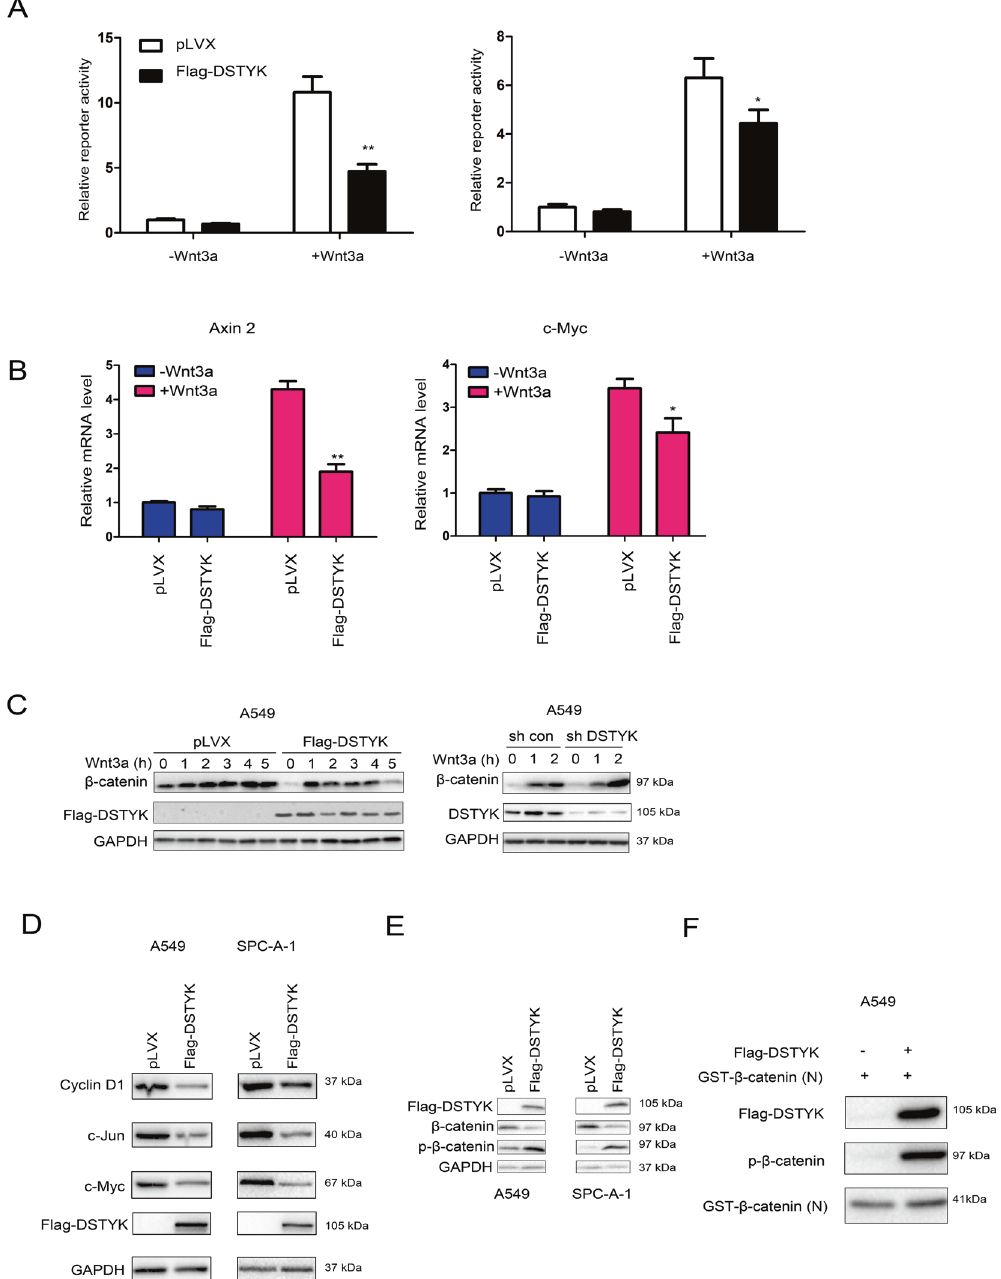
Fig. 5 DSTYK inhibited Wnt/ β -catenin signaling and promoted the phosphorylation of β -catenin. A The TOPFlash reporter assay was performed to examine the effects of DSTYK on the transcriptional activity of β -catenin. B qPCR was performed to examine the effects of DSTYK on the expression of Axin2 and c-Myc. C Western blot was performed to examine the effects of DSTYK on the accumulation of β -catenin. Control cells and DSTYK-overexpressing cells were treated with Wnt3a for the indicated duration, and the protein levels of β -catenin were examined. D Western blot was performed to examine the effects of DSTYK on the expression of cyclin D1 and c-Myc. E The phosphorylation of β -catenin was examined after overexpression of DSTYK. F. In vitro kinase assay. Flag-DSTYK was immunoprecipitated and incubated with GST-N- β -catenin at 32 °C for 30 min, and the phosphorylation of β -catenin was examined. * P < 0.05; ** P <